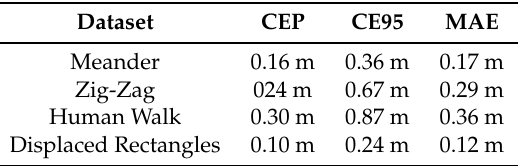
Table 2. Results for general performance